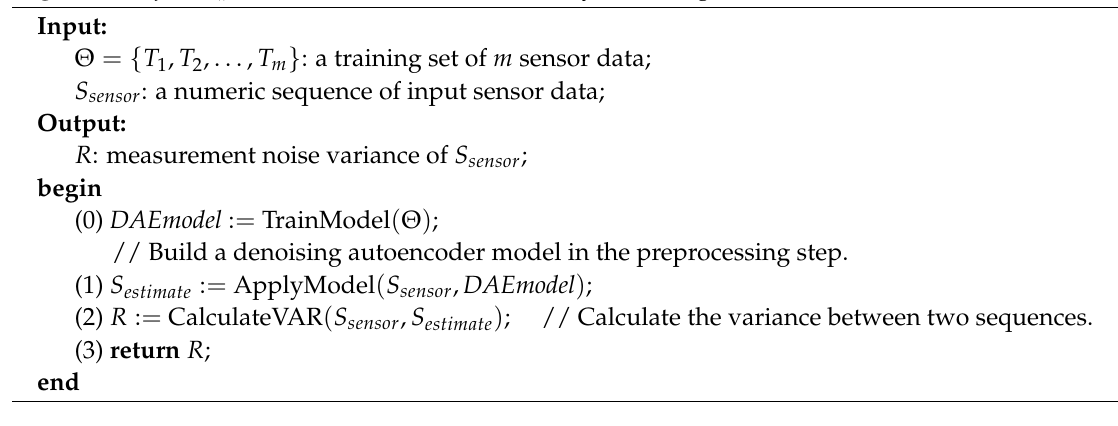
Algorithm 3 f DAE () : Measurement noise variance by denoising